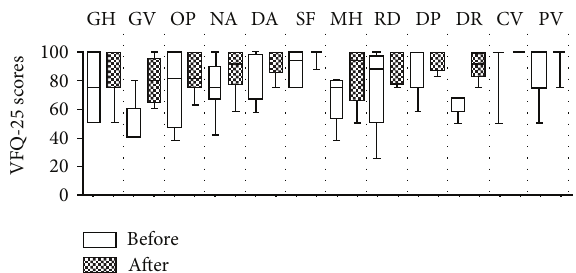
Figure 2: Boxplot of the preoperative and postoperative NEI VFQ- 25 scores in the subscales of general health (GH), general vision (GV), ocular pain (OP), near activities (NA), distance activities (DA), social functioning (SF), mental health (MH), role difficulties (RD), dependency (DP), driving (DR), color vision (CV), and peripheral vision